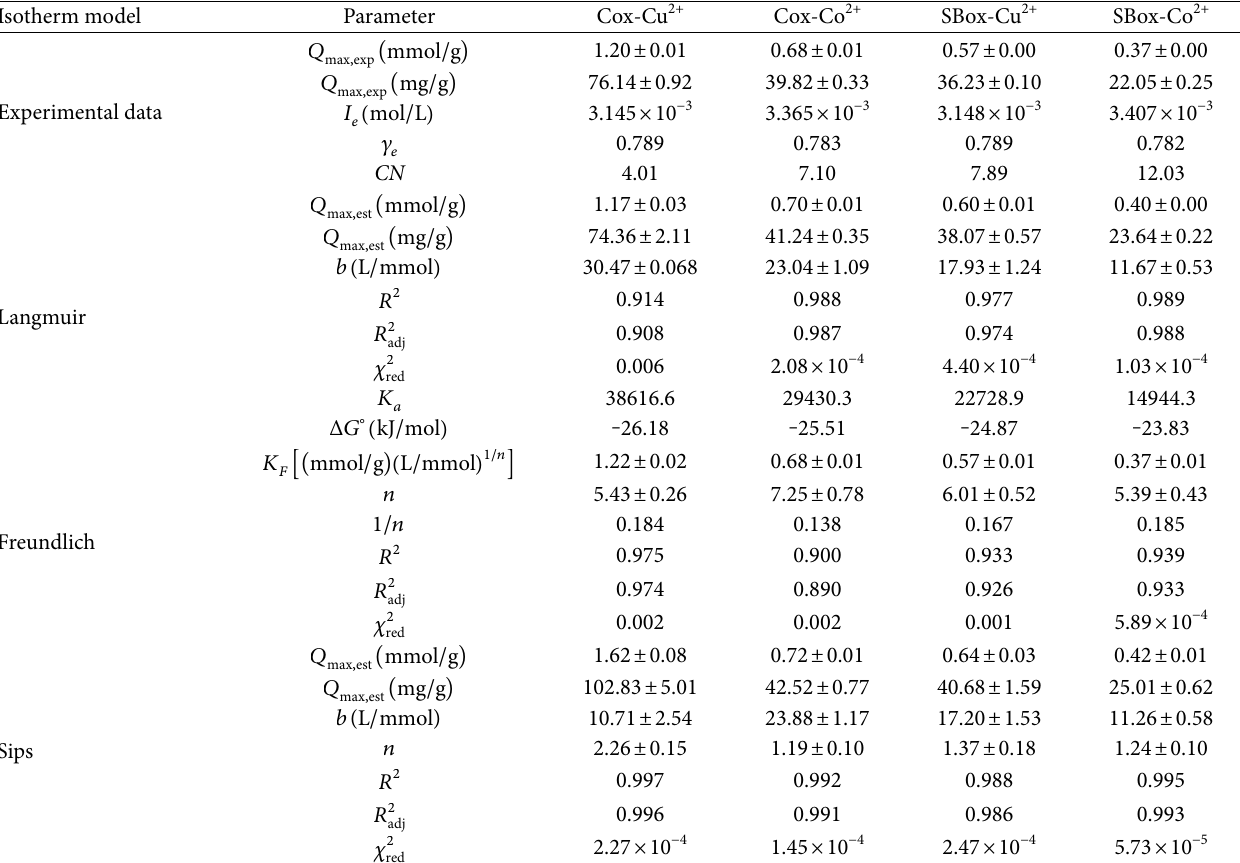
Table 3: Isotherm model parameters estimated for the adsorption of Cu 2+ and Co 2+ on Cox and SBox (pH 5.5, 25°C, 150 rpm and 0.2 g/L Cox or SBox).